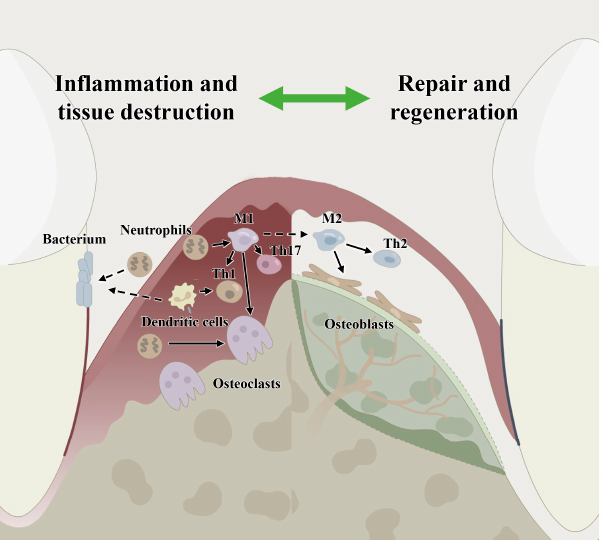
Figure 1. Host immune microenvironment regulation in periodontitis and in periodontal bone remodeling showing the involvement of immune cells, including macrophages, neutrophils, dendritic cells, T cells and host stem cells. M1: classical macrophages; M2: nonclassical macrophages; Th1: T helper cell 1; Th2: T helper cell 2; Th17: T helper cell 17.